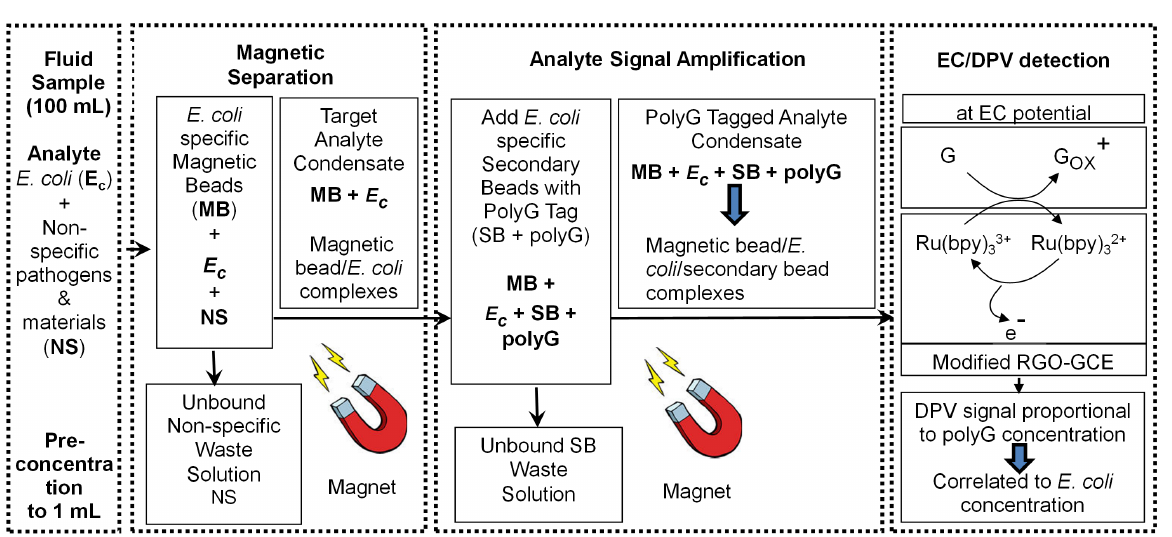
Figure 3. Mechanism of indirect sensing of E. coli O157:H7 using IMS and subsequent signal amplification using polyG functionalized secondary